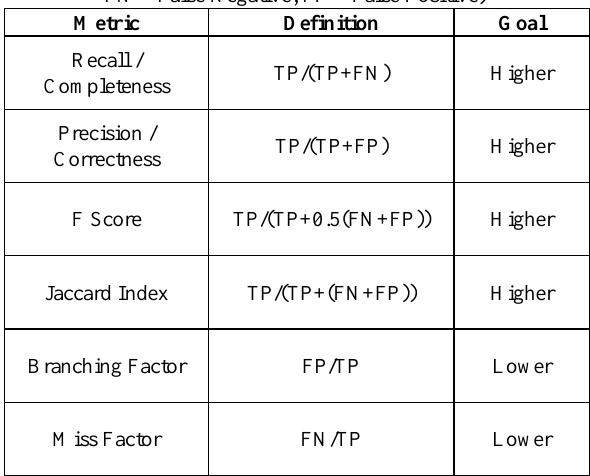
Table 3 Semantic labeling metrics (TP = True Positive,